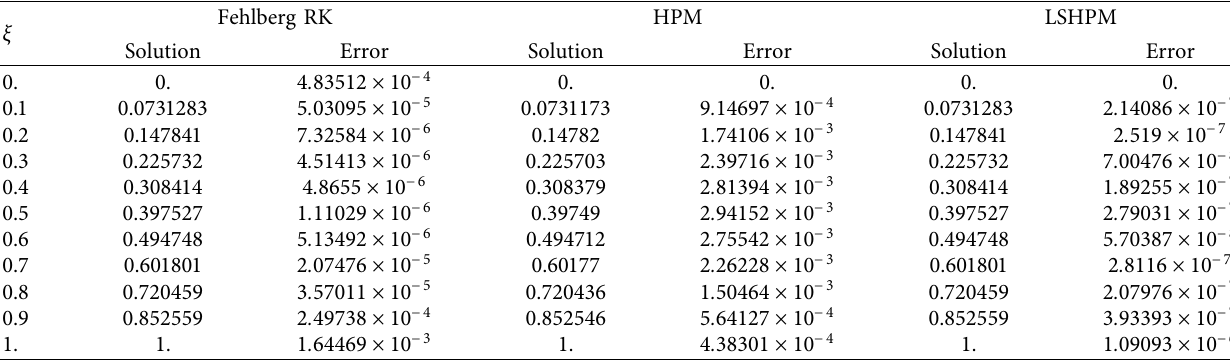
� 0 . 9 , M � 0 . 9, and c � 0 . 9 in case of g p